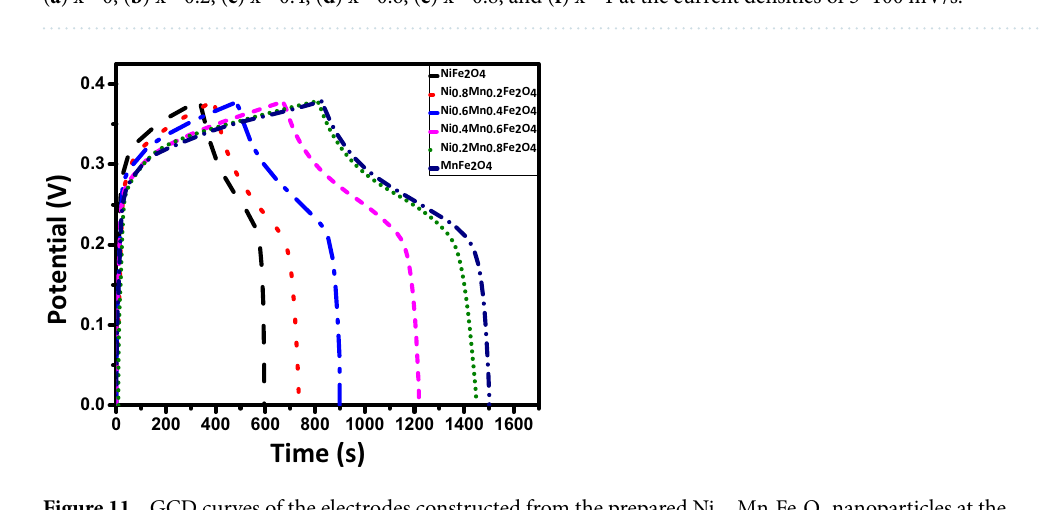
Figure 10. GCD curves of the electrodes constructed from the prepared Ni 1−x Mn x Fe 2 O 4 nanoparticles where ( a ) x = 0, ( b ) x = 0.2, ( c ) x = 0.4, ( d ) x = 0.6, ( e ) x = 0.8, and ( f ) x = 1 at the current densities of 5–100 mV/s.